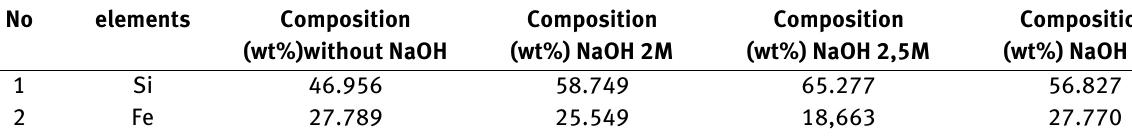
Table 3: Elements obtained from XRF analysis